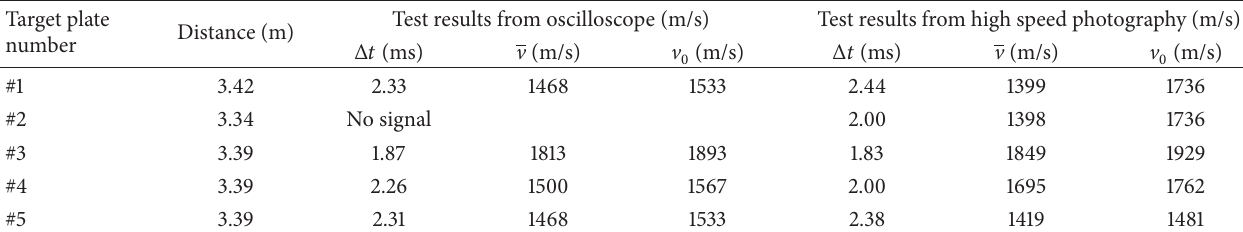
Table 3: Fragment velocity test results of convex-120 ∘